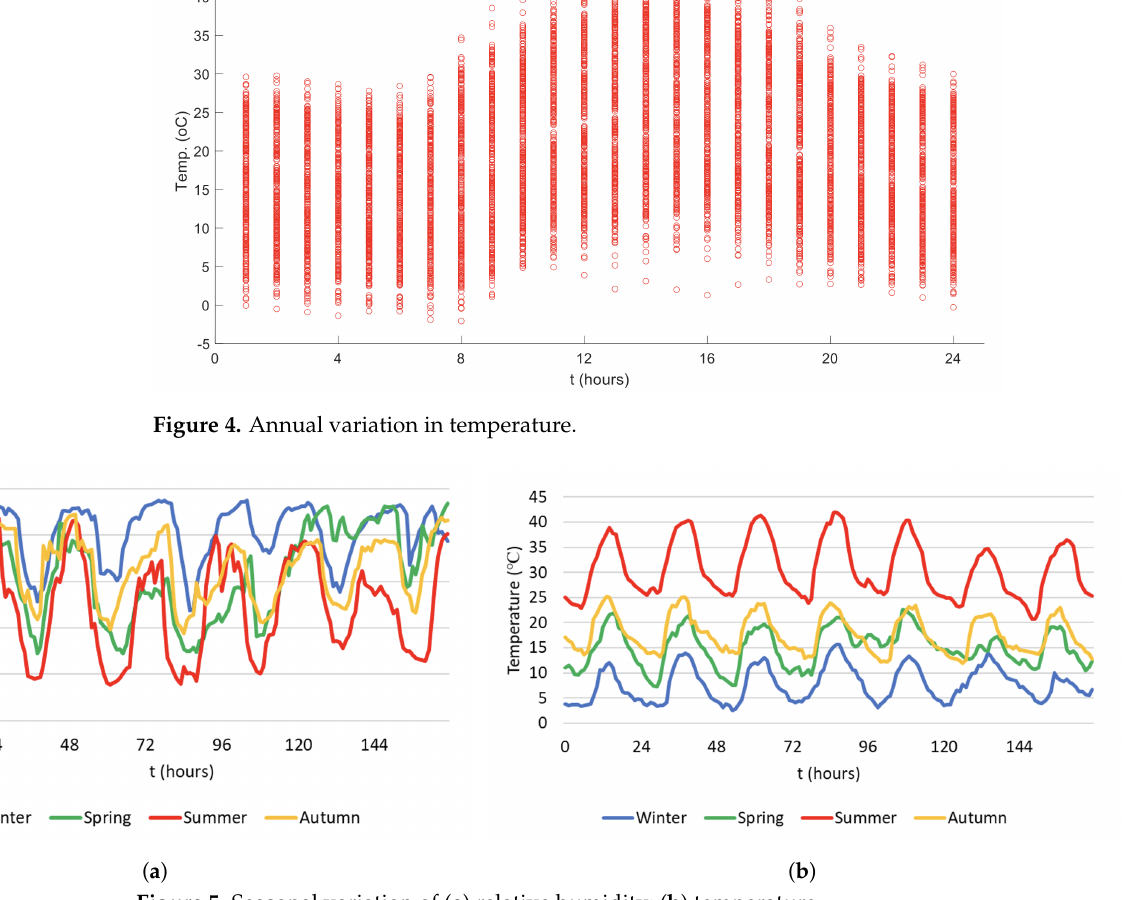
Figure 5. Seasonal variation of ( a ) relative humidity; ( b )